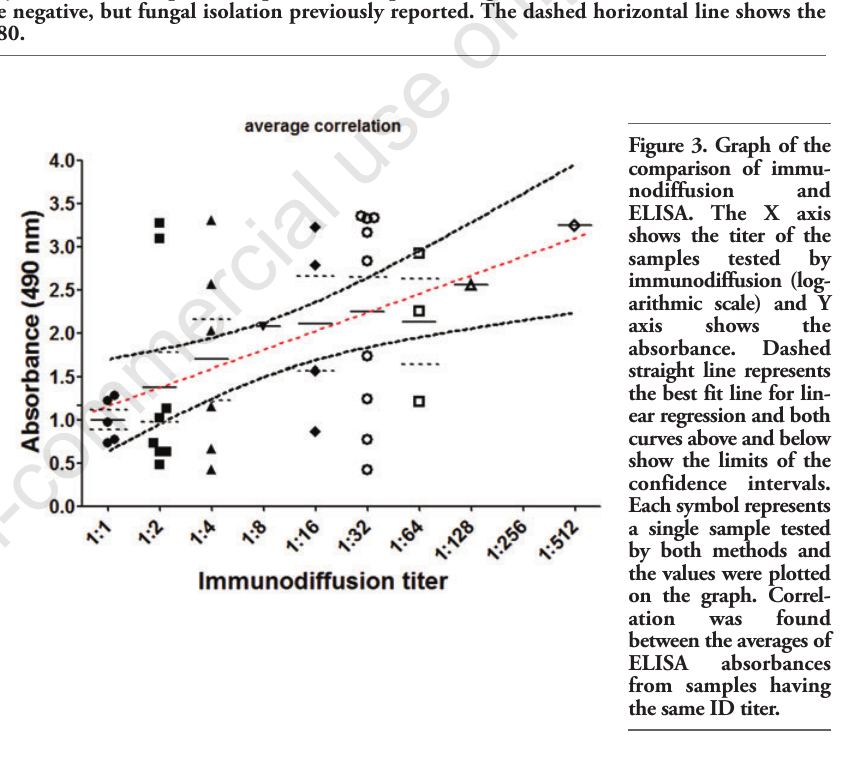
Figure 2. (A) Detection of antibody responses in sera from histoplasmosis patients obtained before treatment, from patients with other proven mycotic diseases and from normal healthy controls by ptHMIN. Hc, Histoplasmosis; Pb, paracoccidioidomycosis; Af, aspergillo- sis; Ss, sporothricosis; Ci, coccidiodomycosis; Cn, cryptococcosis; NHS, normal healthy sera controls. Average for histoplasmosis group was 3.5 times higher than heterologous mycosis group and 7 times higher than normal human serum group (*P<0.001) (B) Detection of antibody responses in sera from histoplasmosis patients, with all clinical manifestations of the disease. All the samples are from patients with proven mycotic diseases. Solid symbols show samples from patients with paired fungal isolation at the moment the sam- ple was obtained, whereas open symbols were negative, but fungal isolation previously reported. The dashed horizontal line shows the cut-off point corresponding to an OD of 0.480.